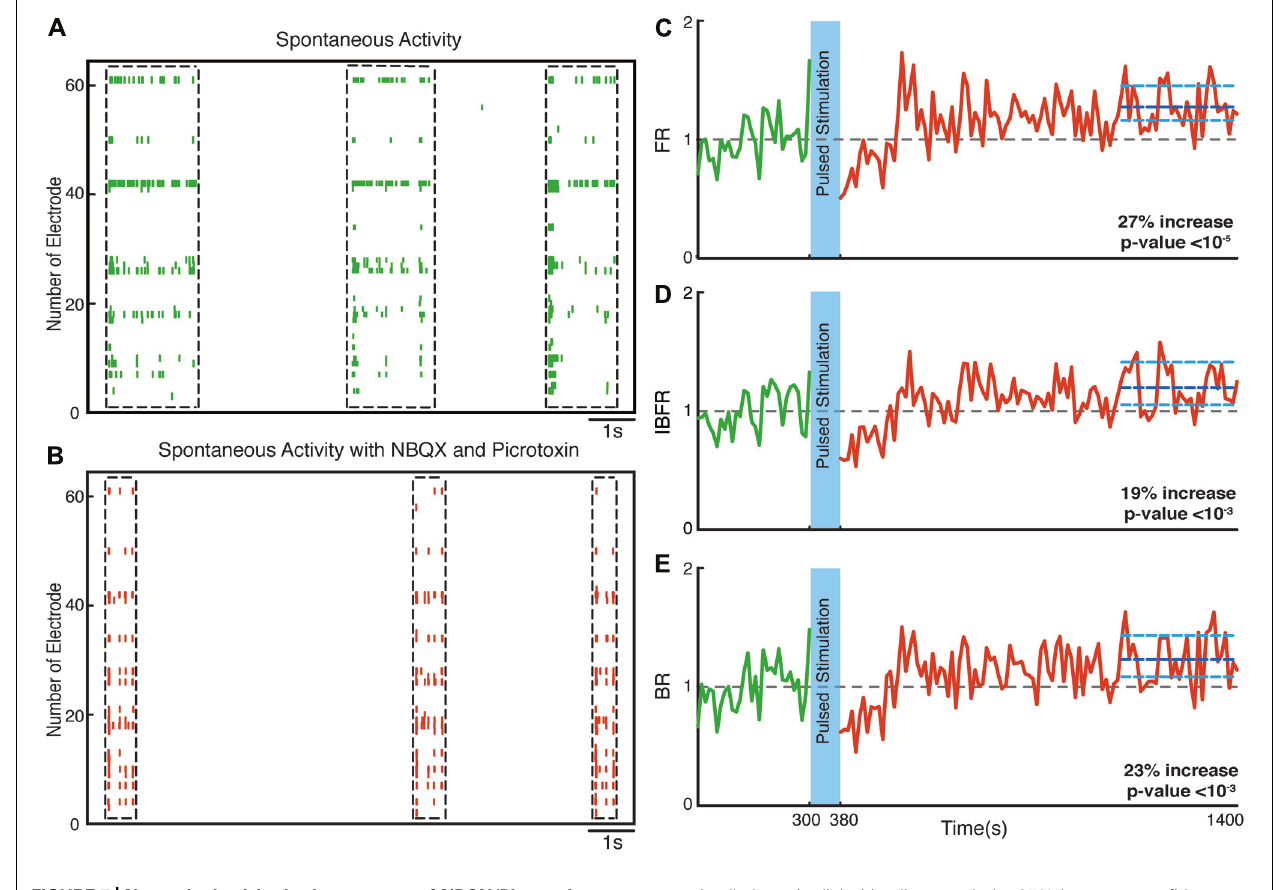
rate. In all plots, the light blue lines mark the 95% bootstrap confidence interval. The light blue column in all figures (300 and 380 s) marks the light stimulation period. P values on each plot give the significance level for the increase of FR, burst occurrence rate, or IBFR during the last 5 min of recording, respectively. The results are averages in 10 experiments in 10